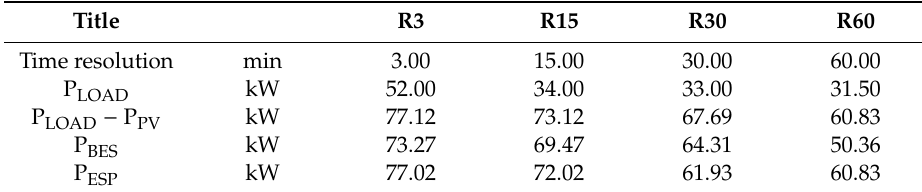
Table 5. Peak values during high